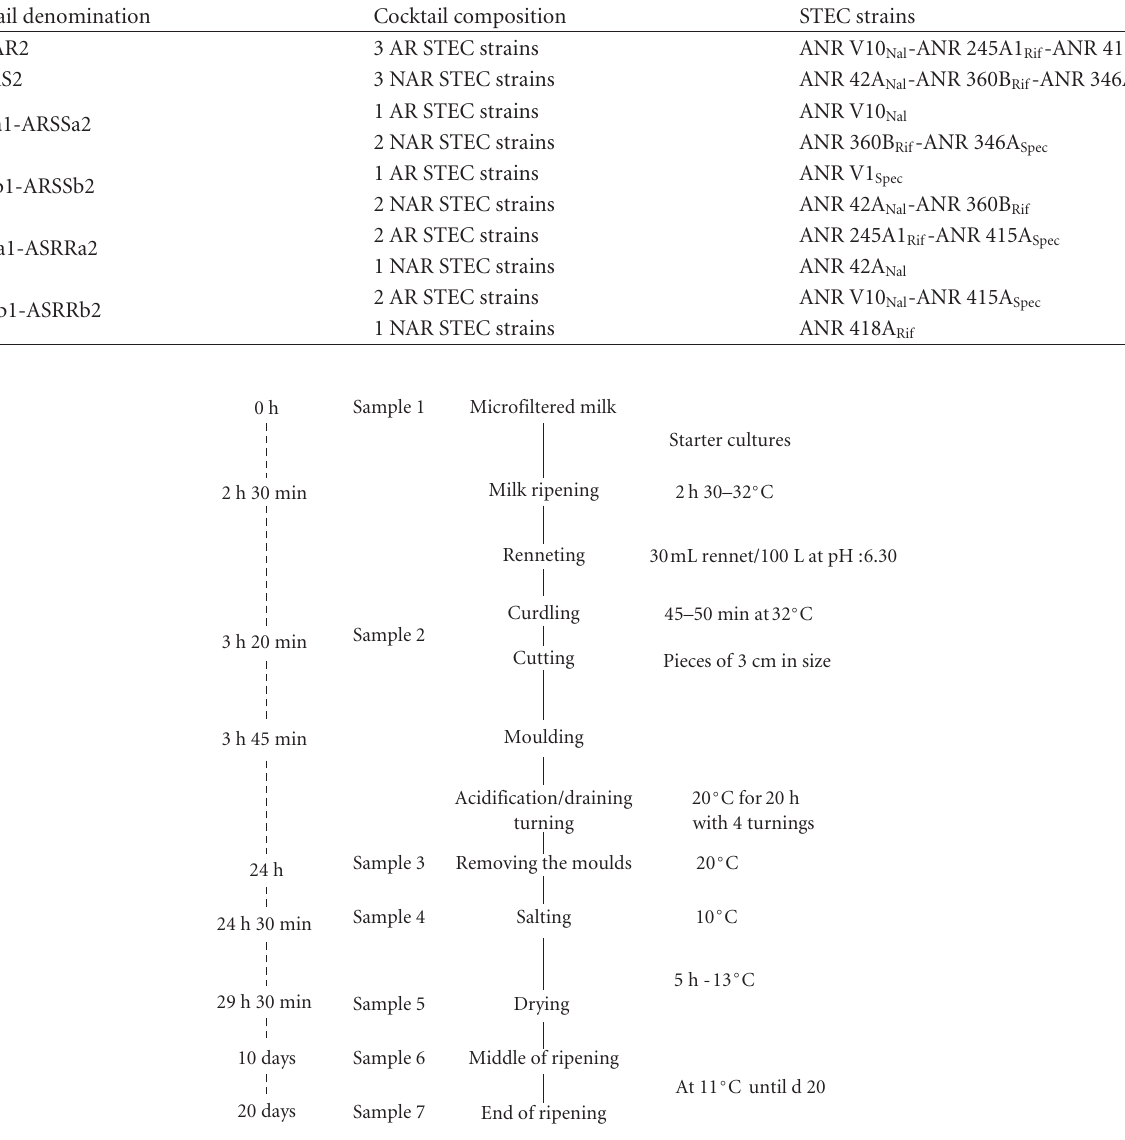
Table 2: Composition of the STEC strains mixtures used for the inoculation of milk.